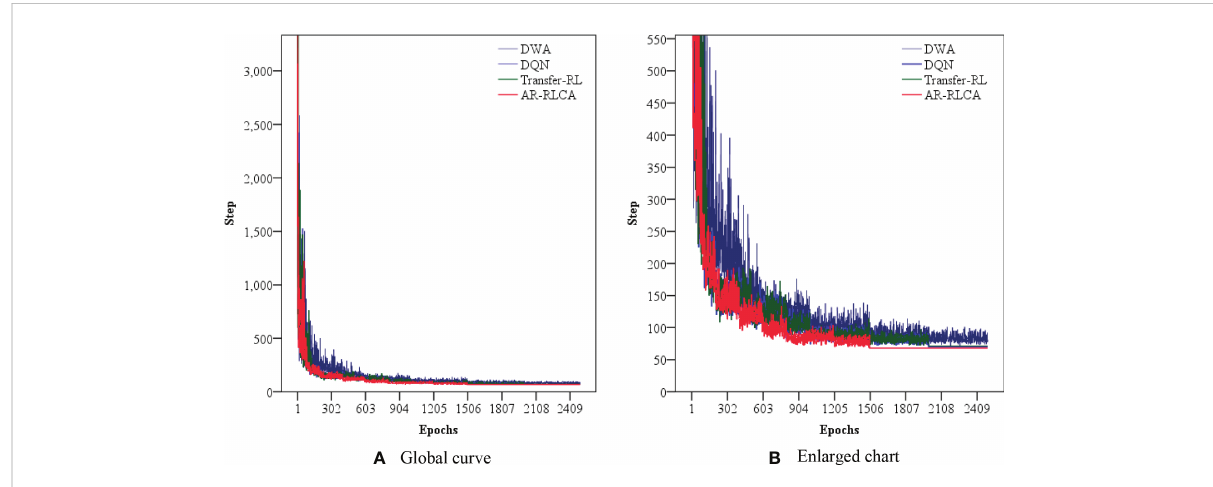
Figure 10A is the global curve of training step – epochs chart.